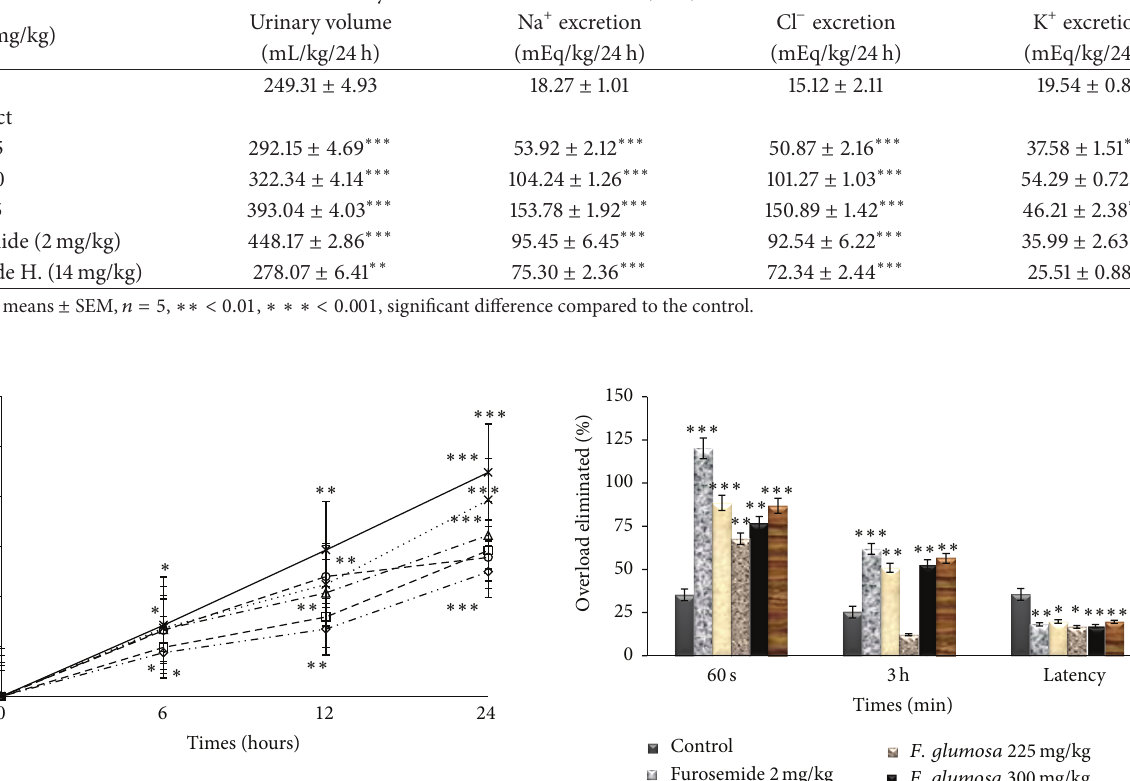
Table 1: Effects of the aqueous extract of F. glumosa on the urinary volume and excretion of Na + , Cl − , and K + . Urinary volume and excretion of Na + , Cl − , and K +